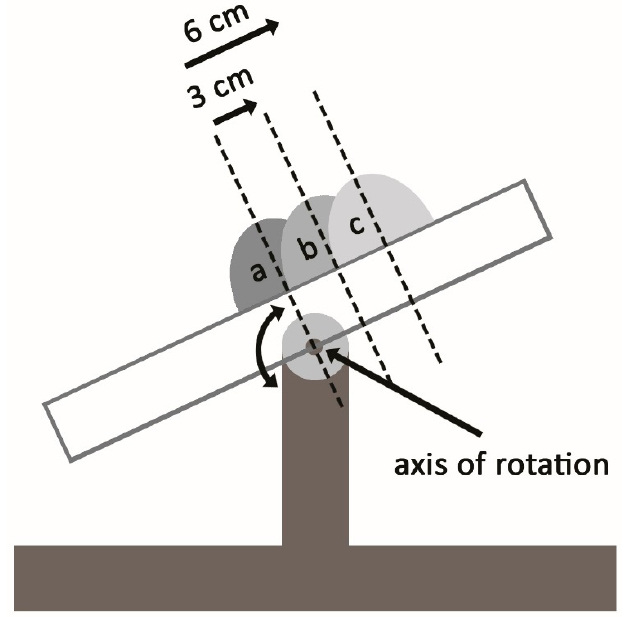
Figure 2. A frontal-plane schematic of the apparatus that enabled simulating di ff erent ski waist-widths. The elliptic shapes represent the left / outside ski-boot in the simulated right ski-turn. The axis of rotation (pointed by the arrow) represents the inner edge of the left (outside) ski. The simulated width of the ski is equal to the doubled distance between the axis of the rotation (ski edge) and the mid of the boot. The positions “b” and “c” simulated the 60 and 120 mm ski waist-widths, respectively. The position “a” is nonrealistic and was used only to collect reference values. The computer-guided electromotor (not shown on the schema) moved the platform with the ski-boot-binding system between the presented positions.